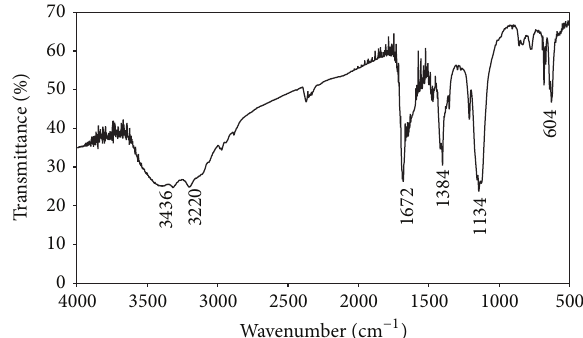
Figure 7: FTIR spectrum of green synthesized silver nanoparticles using M. tinctoria leaf extract.